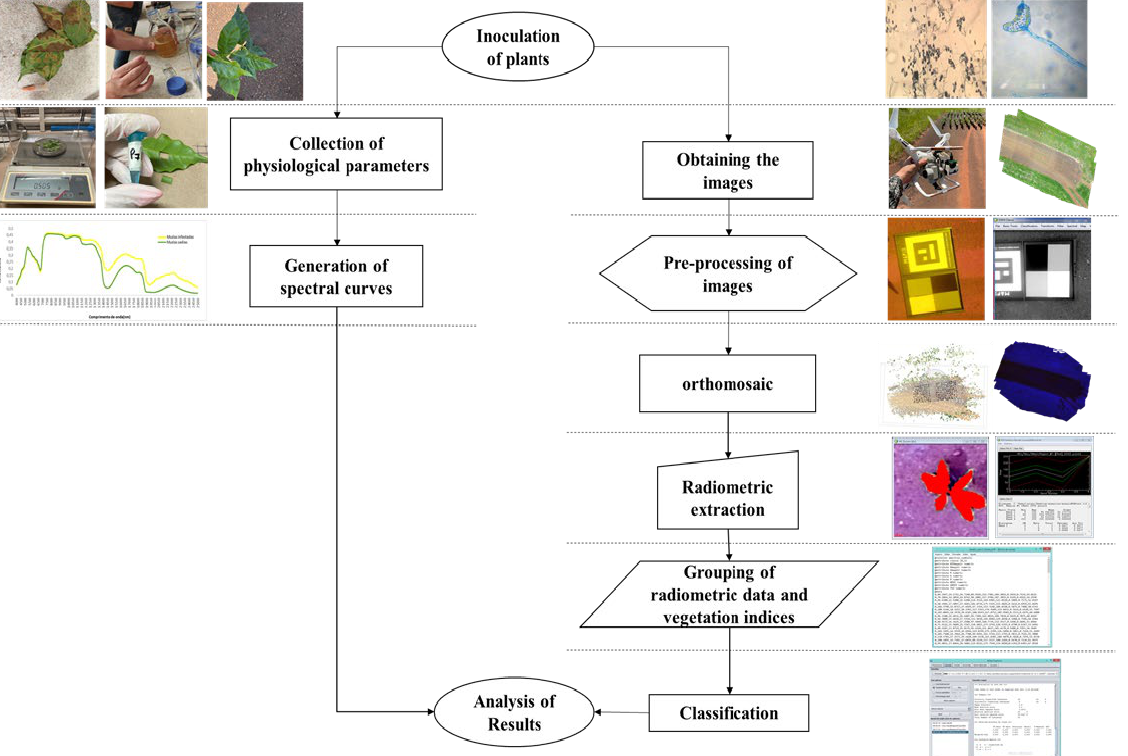
Figure 2. Flowchart of the methodology used in this study.